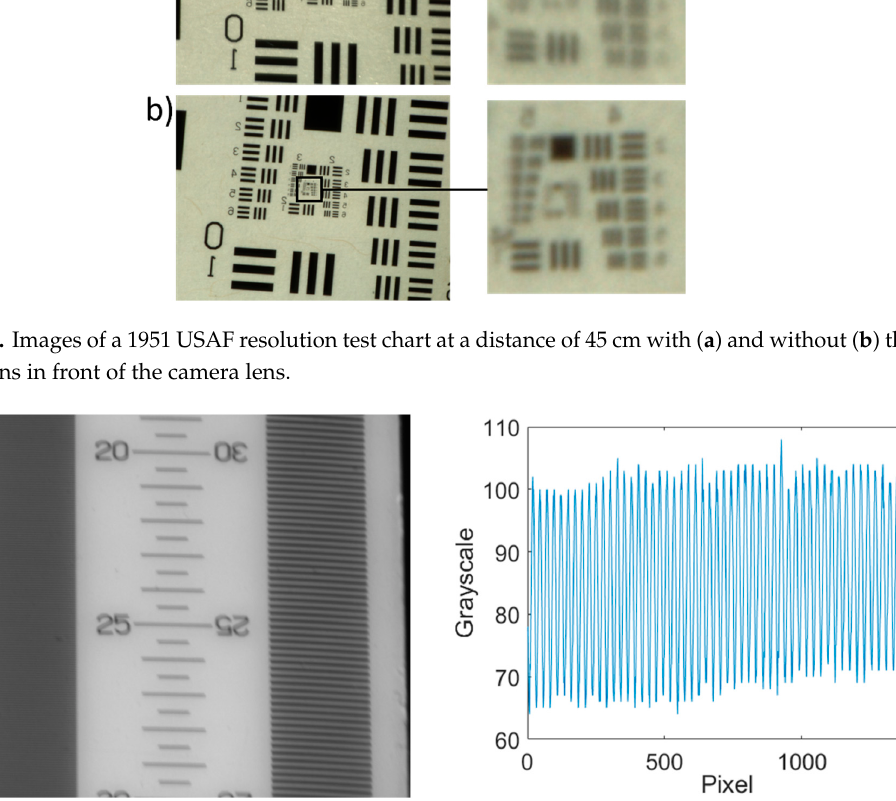
Figure 4. Image of the depth of field target ( left ) and the intensity profile over the left stripe pattern of the image ( right ).